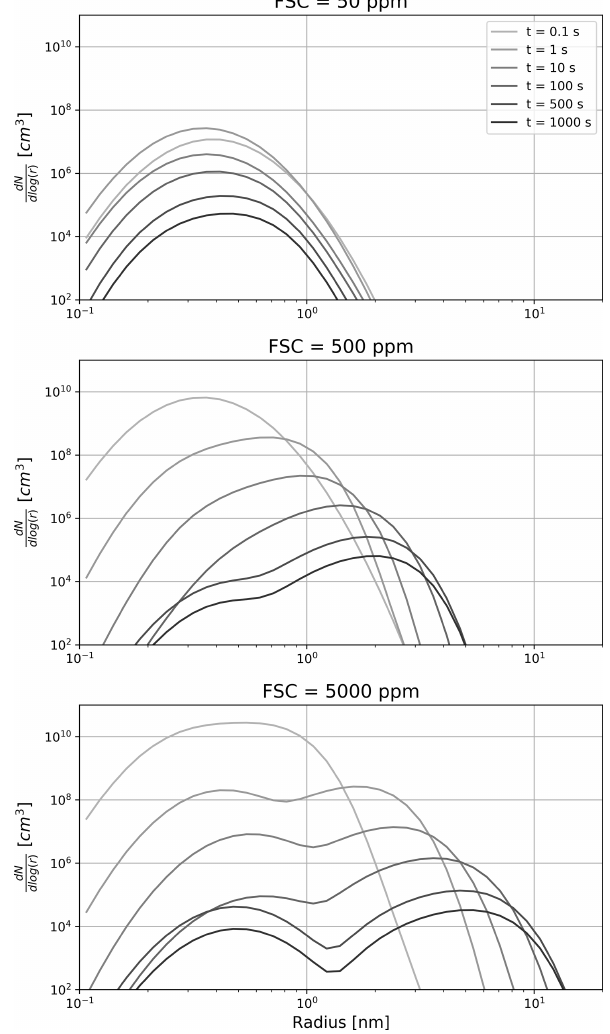
Figure 4. Time evolution of the sulfate aerosol distribution as a function of the fuel sulfur content. From top to bottom, the FSC is set to 50, 500 and 5000ppm on a mass basis. The color shading depicts the time evolution, with lighter shading corresponding to a younger